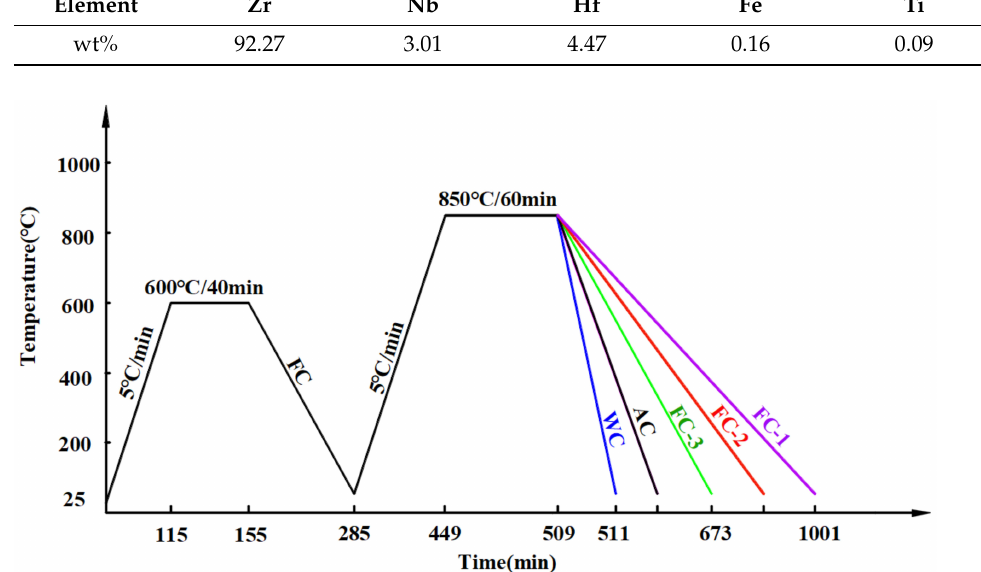
Figure 1. The schematic diagram of the heat treatment processing route.